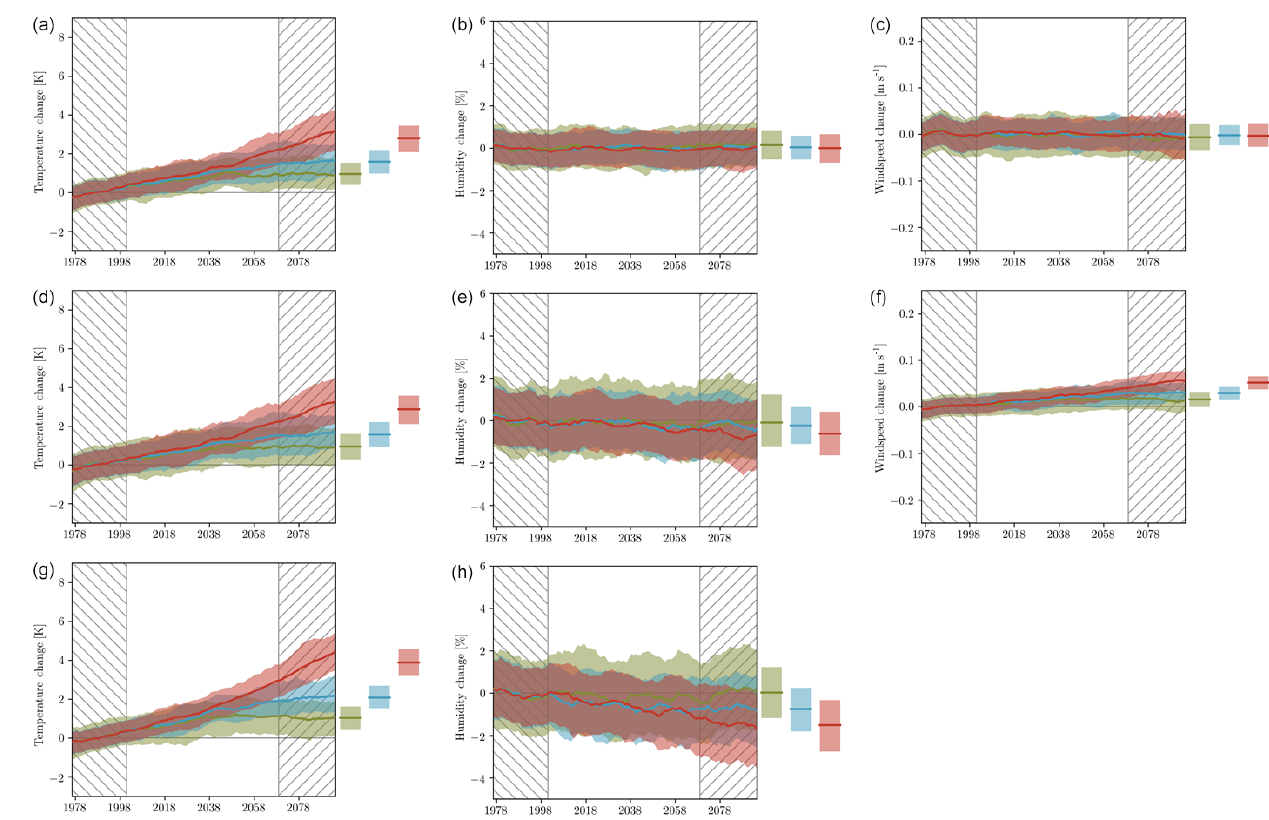
Figure 3. Projected change in indoor temperature, humidity and wind in the three focus regions of this study under RCP 2.6 (green), RCP 4.5 (blue) and RCP 8.5 (red). Regions: central European maritime region with reference weather station Rostock-Warnemünde (a–c) , central European continental region with reference weather station Potsdam (d–f) and western Mediterranean region with reference weather station Valencia (g, h)